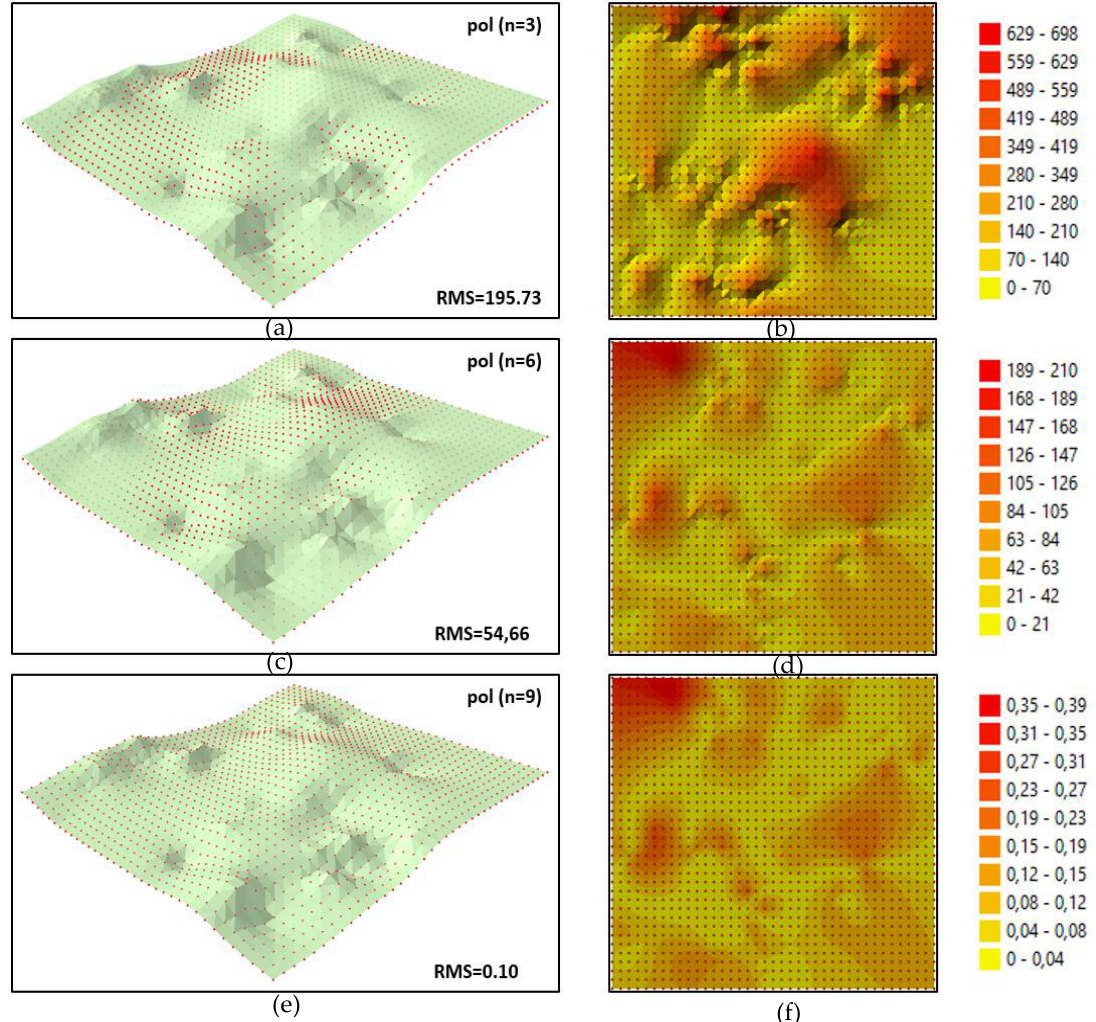
Figure 5. A comparison of the accuracy with which the recreated GRID nodes were fit to the original surface (2012 data) for di ff erent degrees (n) of the polynomials generated with the use of all measurement epochs: ( a ), ( c ), ( e )—original surface and reconstructed nodes; ( b ), ( d ), ( f )—di ff erential diagrams. Source: own elaboration.